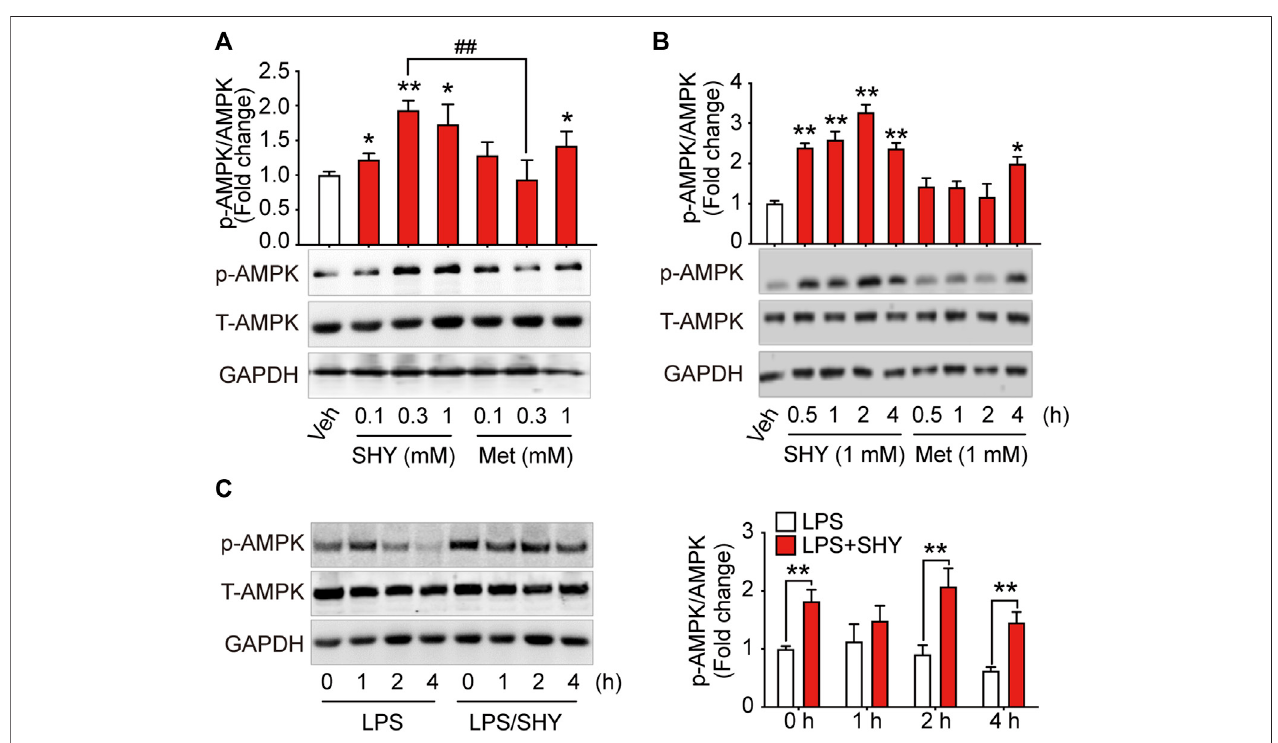
FIGURE 1 | SHY-01 rapidly activates AMPK in microglia. (A) BV-2 microglial cells were treated with various concentrations of SHY-01 (SHY) or metformin hydrochloride (Met) for 1 h, PBS was used as vehicle (veh) control. Phosphorylation of AMPK (Thr 172) was detected by Immunoblot. p p < 0.05, pp p < 0.01 versus the vehicle control, ## p < 0.01 represent 0.3 mM Met versus 0.3 mM SHY-01. (B) BV-2 microglial cells were treated with 1 mM SHY-01 (SHY) or Met for indicated time points. p p < 0.05, pp p < 0.01 versus the vehicle control. In (A,B) , phosphorylated (p)-AMPK (Thr 172) protein levels were expressed relative to vehicle (veh) control as mean ± SD ( n = 3) and data were analyzed using one-way ANOVA followed by Dunnett post hoc tests. (C) BV-2 microglial cells were pre-incubated with 1 mM SHY- 01(SHY)followedwithLPS(200 ng/ml)challengefor0,1,2,or4 h.CellswerecollectedforImmunoblotanalysisofp-AMPK(Thr172),totalAMPKandGAPDH.Relative p-AMPK protein levels were expressed as mean ± SD ( n = 3), data were analyzed using two-way ANOVA followed by Dunnett ’ s post hoc tests. pp p < 0.01 versus the LPS